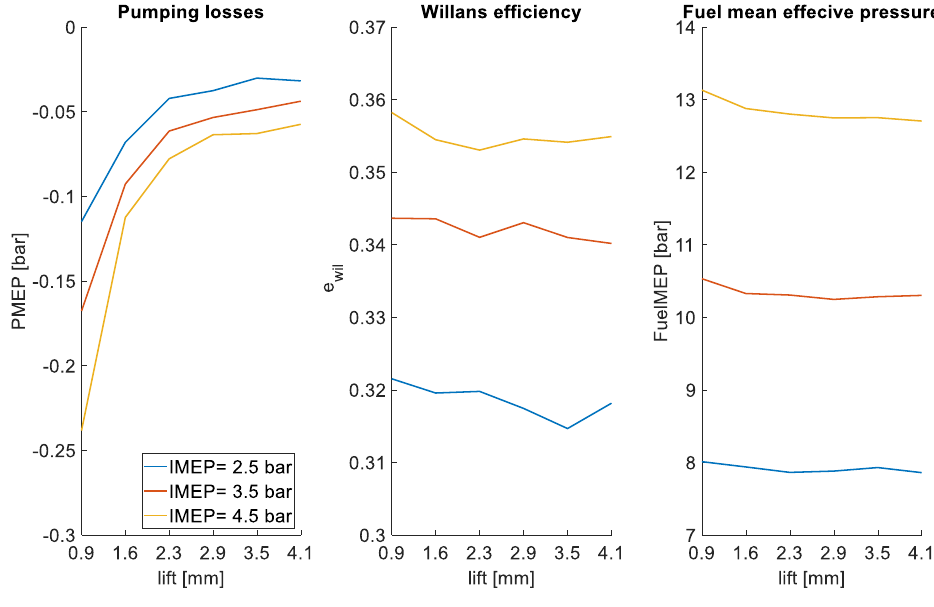
Figure 8. Willans Figure 8. Willans pararameters.